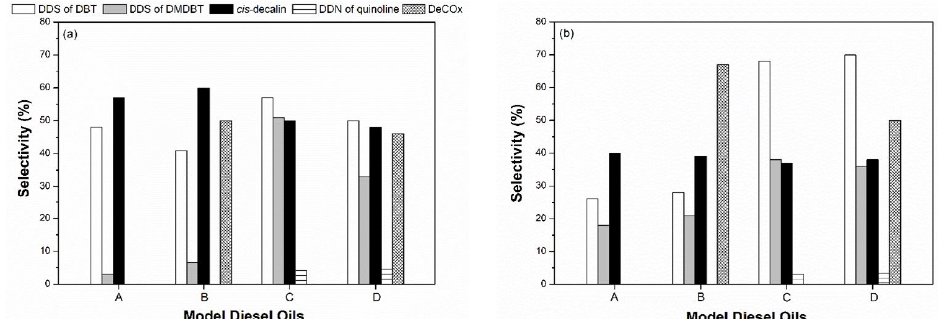
Figure 7. The selectivity of the mesoporous sulfide catalysts ( a ) CoMo/γ-Al 2 O 3 and ( b ) NiMo/γ-Al 2 O 3 in the hydrotreating of model diesel oils A–D at 330 C and 5 MPa of H 2 for 1 h. Recent studies have shown that the catalytic activity and selectivity of mesoporous CoMo/γ- Al 2 O 3 and NiMo/γ-Al 2 O 3 sulfide catalysts in the hydrotreating of petroleum- and coal-derived oils are not only associated with surface fine structures of Co- and Ni-incorporated MoS 2 -like slabs as the catalytically active sites, but also strongly influenced by the spatial location of heteroatom-containing compounds, such as H 2 S or amines, competitively adsorbed on the catalytically active sites [25,26,28– 33]. In the HDS of DBT and DMDBT, it is generally agreed that the catalytically active sites for the DDS pathway are associated with the CUS regions at the edges or corners of Co- and Ni-incorporated MoS 2 -like slabs, so-called the Co(Ni)-Mo-S structures, while those for the HYD pathway are related to the brim sites, which exhibit metal-like character [25,26]. In the upgrading of model diesel oil A over the mesoporous CoMo/γ-Al 2 O 3 sulfide catalyst, there is no doubt that small Co-incorporated MoS 2 -like slabs with high stacking numbers are highly efficient in the HDS of DBT toward the DDS product, which is catalyzed by the Co-Mo-S structures at the edges or corners. In contrast, the main HDS route of DMDBT is the HYD pathway, which is catalyzed by the brim sites because of steric hindrance [31]. The hydrotreating activity of the mesoporous NiMo/γ-Al 2 O 3 sulfide catalyst in the hydrotreating of model diesel oil A is poor by comparison, suggesting that large Ni-incorporated MoS 2 -like slabs with lower stacking numbers contain relatively low numbers of catalytically active sites, i.e., the Ni-Mo-S structures, and show relatively low activity for HDS reactions. However, the HYD of tetralin to trans -decalin over the brim sites is significantly enhanced, presumably because of the high electron density of the brim sites, which facilitate hydrogen dissociation corresponding to the high HYD ability of the large Ni-incorporated MoS 2 -like slabs [25]. The variation in selectivity for the HDS of DBT and DMDBT over the mesoporous sulfide catalysts could be related to their competitive adsorption on the catalytically active sites.